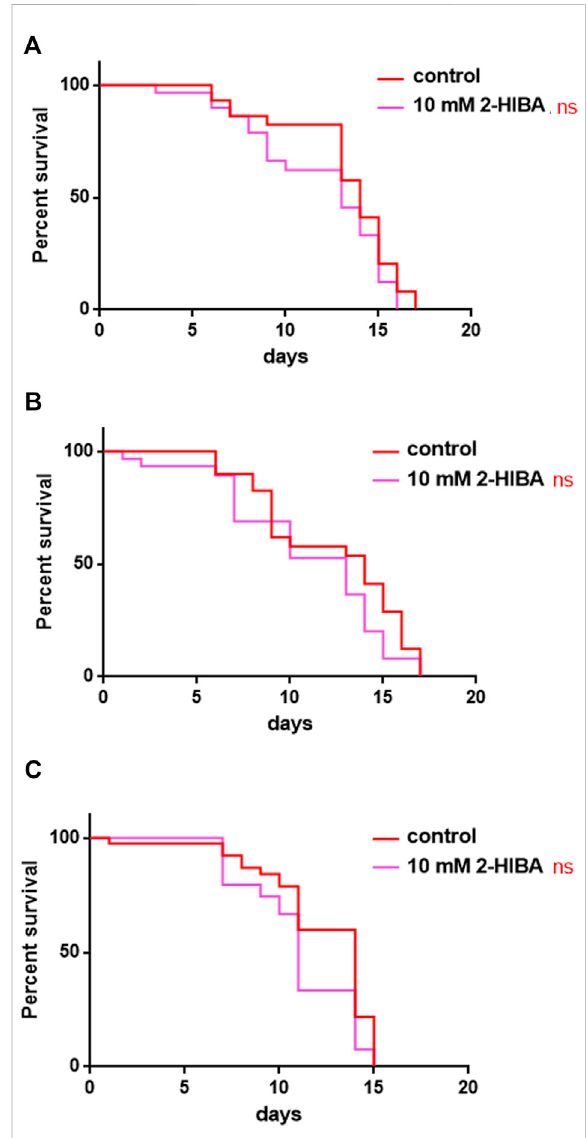
FIGURE 7 Effect of 10 mM 2-HIBA on pmk-1 , sek-1 and skn-1 mutant animals. (A) Kaplan-Meier survival plot of (A) pmk-1, (B) sek-1, (C) skn-1 mutantwormssupplementedwith10 mM2-HIBA.Lifespans of untreated worms (control) were taken as reference; n = 60 for each data point of single experiments (ns: not signi fi cant). The experiment was performed in